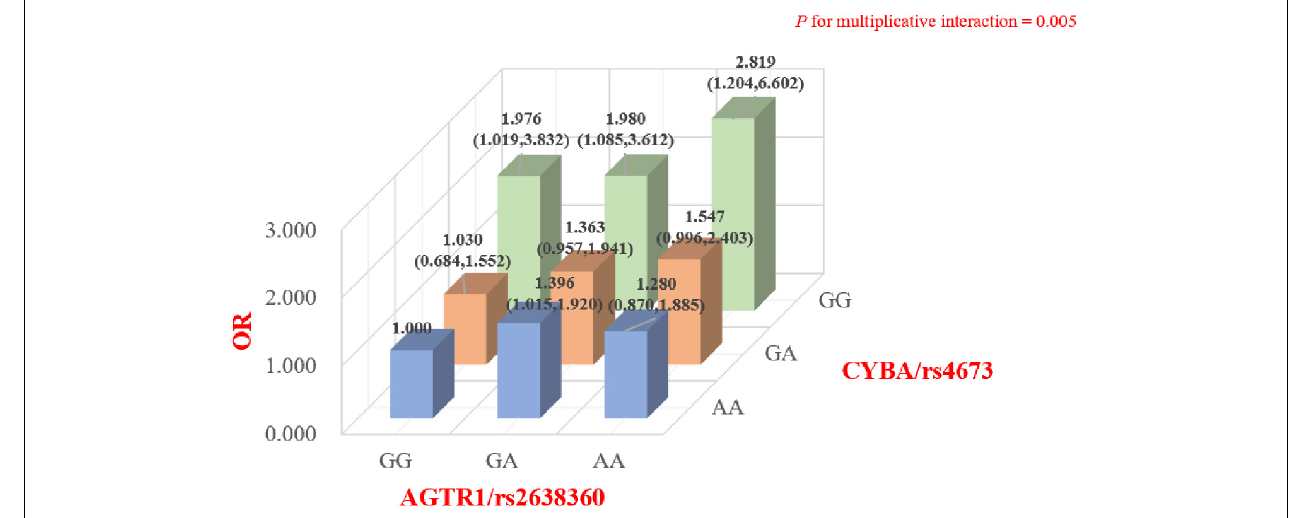
FIGURE 2 | The interaction between CYBA/rs4673 and AGTR1/rs2638360.